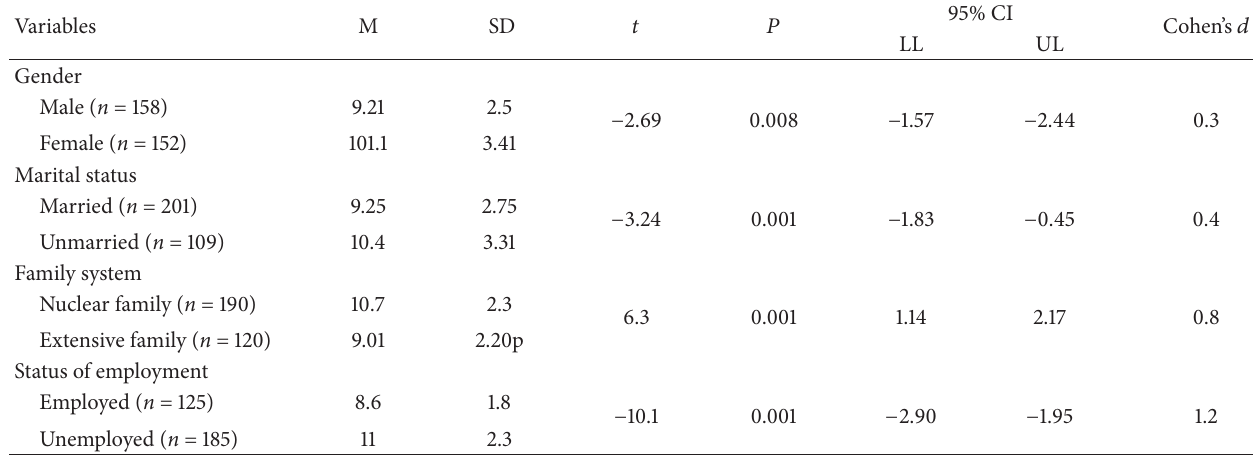
Table 2: Mean differences in various demographic variables among elderly ( 𝑁 =